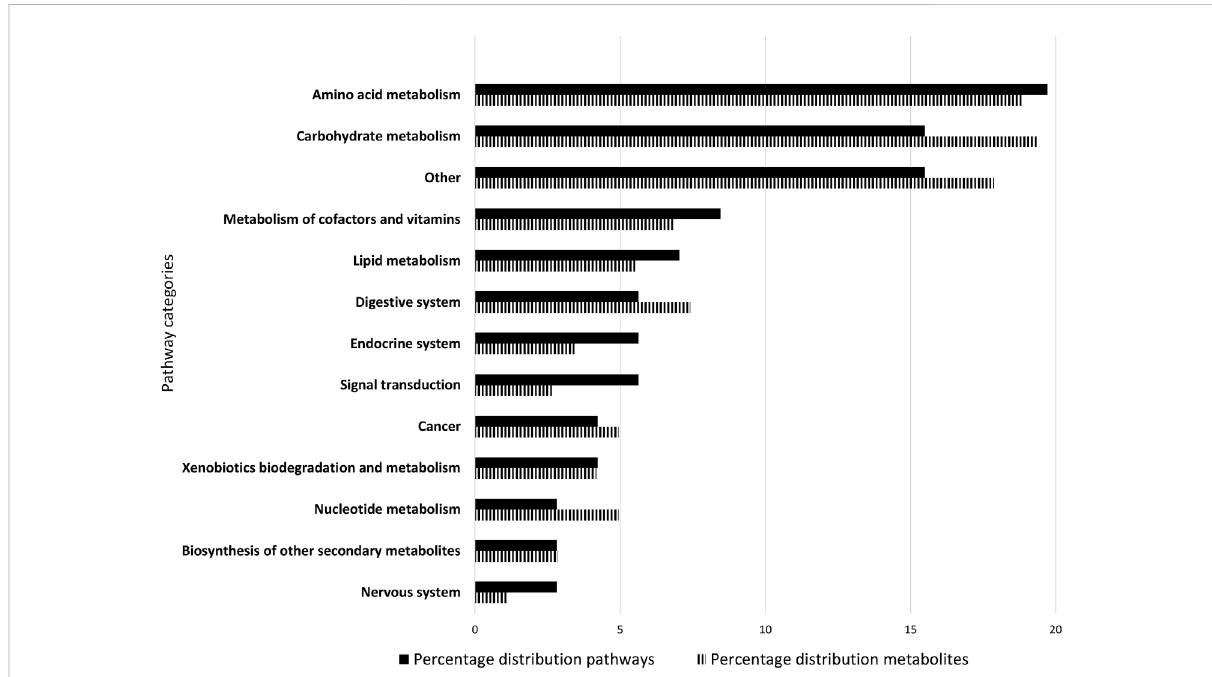
FIGURE 2 Composition of the Caco-2 metabolome. The 71 metabolic pathways of the Caco-2 metabolome were classi fi ed into 13 categories. The classi fi cation was based on the KEGG nomenclature. Main categories to which only one pathway belongs were aggregated under “ Other ” . The bar chartshowsthepercentageofmetabolicpathwaysassignedtomaincategoriesinblack,andthecorrespondingdistributionofmetabolitesinstriped. The fi gure is ranked according to the percentage of pathways assigned from largest to smallest